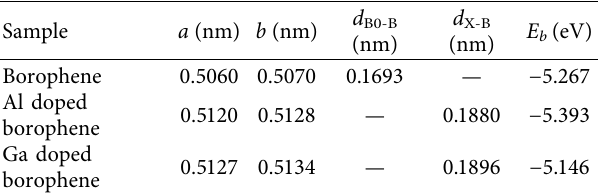
Figure 1: Model of α -sheet borophene. (a) Undoped; (b) Al doped; (c) Ga doped. Table 1: Structural parameters and binding energy of α -sheet borophene ( X � Al, Ga).